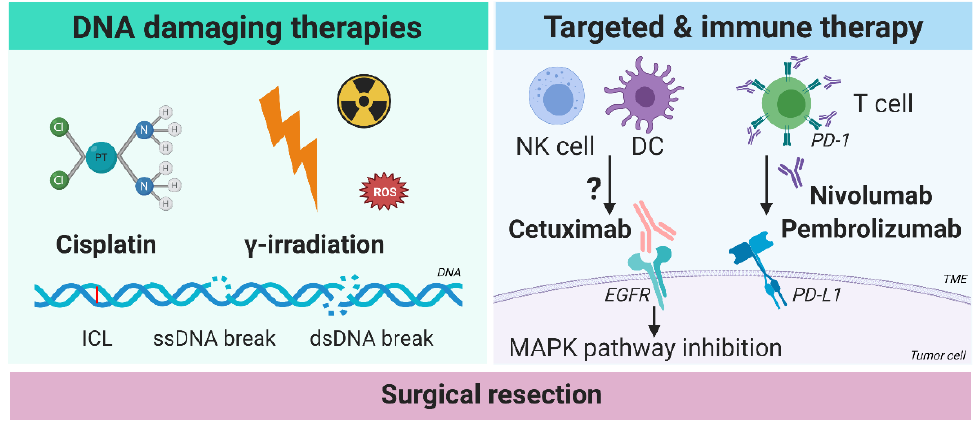
Figure 1. Approved and clinically applied treatment interventions for HNSCC. Early stage HNSCC is treated with either surgery or radiotherapy with photons or protons, while advanced stage HNSCC is treated by either upfront cisplatin-based chemoradiotherapy and salvage surgery when required, or upfront surgical resection with post-operative (chemo-)radiation. For patients unfit to receive cisplatin, the anti-EGFR monoclonal antibody cetuximab can be applied. Furthermore, patients with recurrent or metastatic disease are treated by the EXTREME protocol and with anti-PD-(L)1 antibodies, such as nivolumab and pembrolizumab, although response rates are low and clinical biomarkers for response are still under investigation. Abbreviations: ROS: reactive oxygen species, ICL: inter-strand crosslink, ssDNA break: single strand DNA break, dsDNA break: double strand DNA break, NK cell: natural killer cell, DC: dendritic cell, T cell: T lymphocyte, PD-1: programmed cell death protein 1, TME: tumor microenvironment, EGFR: epithelial growth factor receptor, PD-L1: programmed death-ligand 1, MAPK: mitogen-activated protein